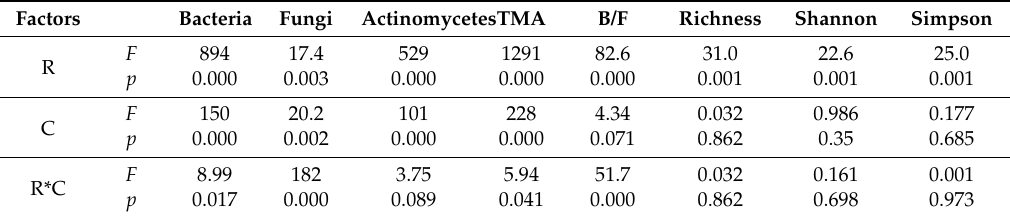
Table 4. Results ( F and p values) of two-way ANOVA of the effect of rice straw (R) and biochar (C) addition on soil microbial abundances and diversity.